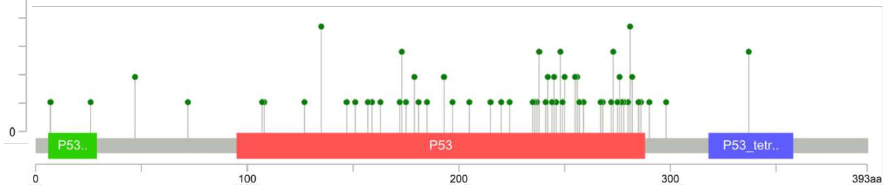
Figure 2. The primary structure of p53 protein with marked domains and amino acid codons showing the number of missense mutations. The X-axis represents the p53 amino acid sequence, Y-axis number of found substitutions. Transactivation domain (green); Core domain which can bind DNA (red); oligomerization domain (blue). Figure created basing on the data published in references [80 – 93] using cBioPortal Mutation Mapper [94,95] .